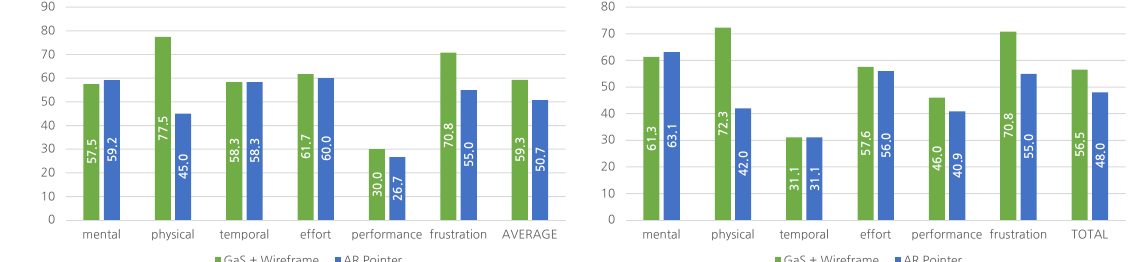
Figure 9. NASA task load index (NASA-TLX) questionnaire survey